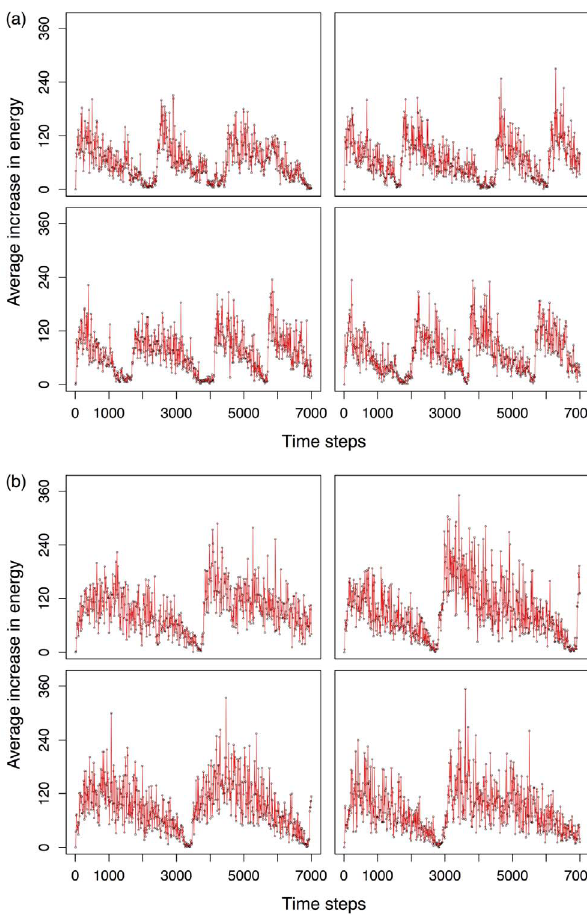
Figure 5. Average increase in energy for robots with ANN versus GRN controllers. The Y-axis represents the average (of the entire robot population) increase in energy measured over ten time steps, while the X-axis represent running time measured in time steps. a) Four consecutive simulations are shown for robots with ANN controllers. b) Four consecutive simulations are shown for robots with GRN controllers. Drops are caused by food resource exhaustion. When the number of robots in the population drops below 100, food resources are initialised again (see Text S5), causing the population to recover. See text for details.